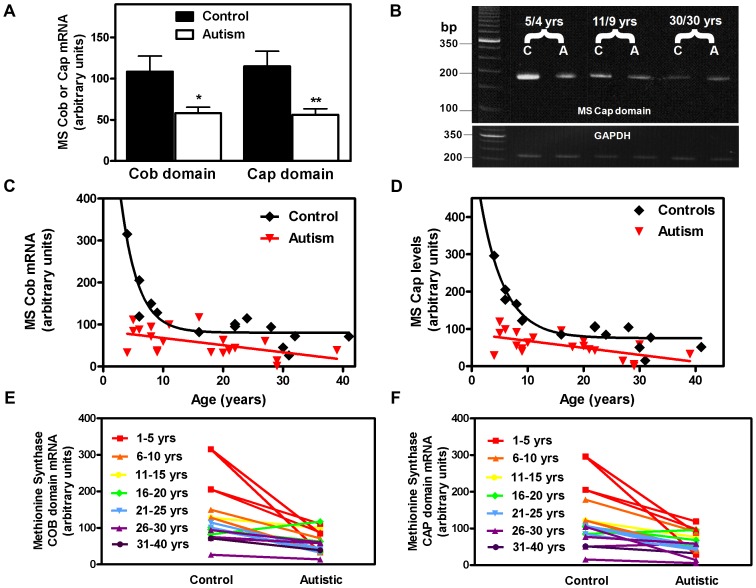
Status of human cortex MS mRNA in autism.(A) Levels of cobalamin-binding (Cob) and cap domain (Cap) mRNA in grouped control vs. autistic subjects. * and ** indicate significant decreases compared to control group (p = 0.01 and 0.003, respectively). (B) Cobalamin-binding domain PCR products for age-paired control (C) and autistic (A) subjects. Age-pairs were 5 and 4 years, 11 and 9 years and 30 years. (C) Age-dependent levels of cobalamin-binding domain mRNA. Control data was best fit to an exponential decay function (T1/2 = 2.3 years; R2 = .97); Autism data was best fit to a linear function with slope not significantly different from zero. (D) Age-dependent levels of cap domain mRNA. Control data was best fit to an exponential decay function (T1/2 = 2.7 years; R2 = .94). Autism data was best fit to a linear function with slope not significantly different from zero. (E) Pair-wise comparison of cobalamin-binding domain mRNA for different autism age groups. (F) Pair-wise comparison of cap domain mRNA for different autism age groups.